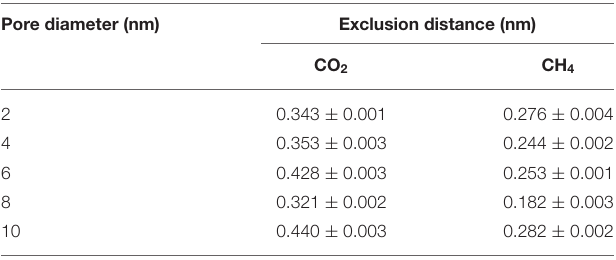
TABLE 1 | The exclusion distance (nm) of CO 2 and CH 4 in CH 3 -terminated pores as a function of the pore diameter. Pore diameter (nm)